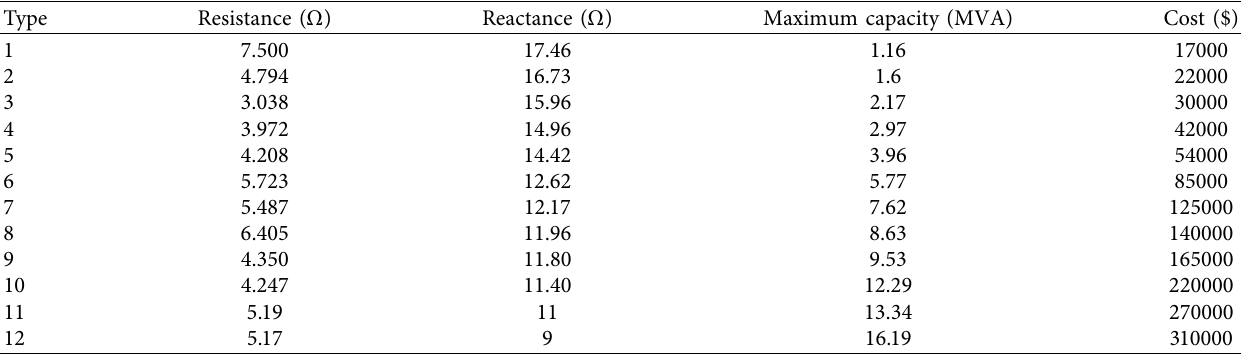
Table 4: Specification of wires.